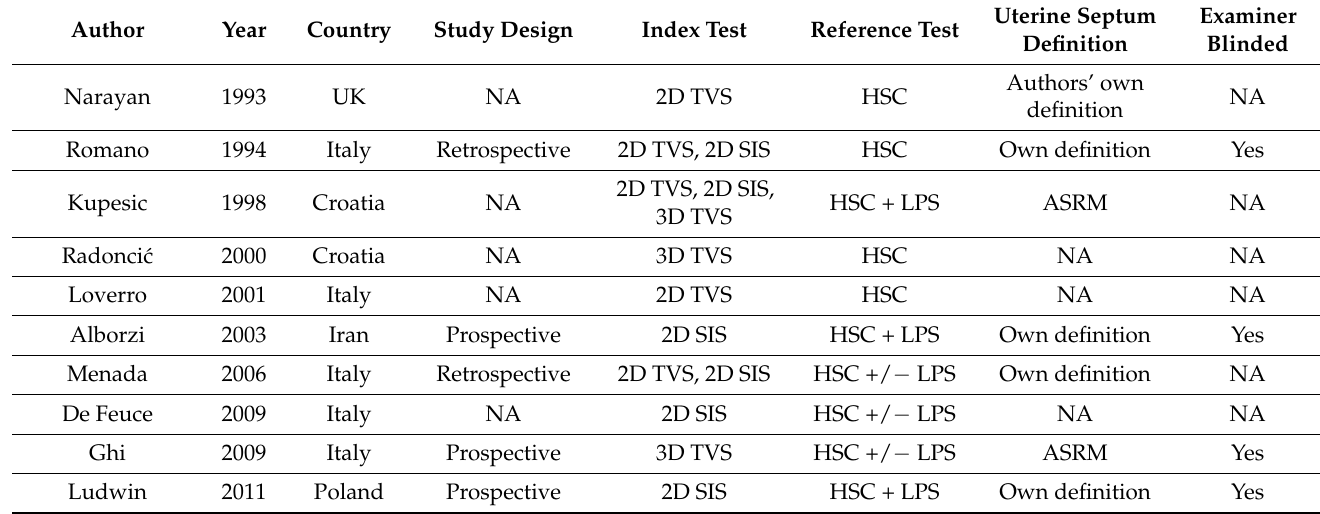
Table 1. Main characteristics of the studies included in the